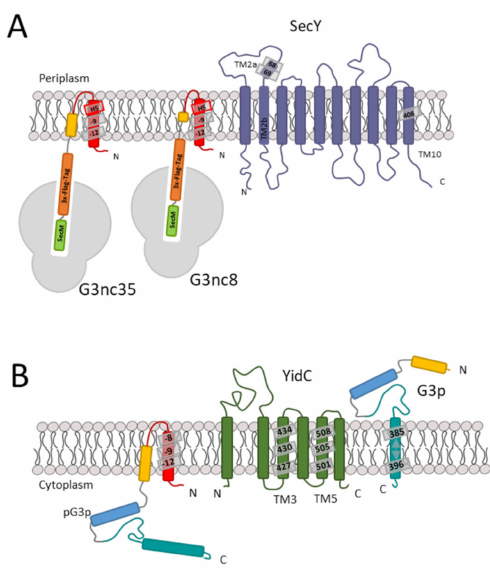
Figure 7. Stages of membrane insertion of G3p. ( A ) In the first stage, when the nascent chain of G3p exposing the signal sequence interacts with SecY of the translocase, namely in the plug region, the residues 68 and 69 are predominant. ( B ) In the second stage, the periplasmic region of G3p is translocated by SecA and SecYEG. The membrane anchor region of G3p is then inserted by contacting the YidC hydrophobic slide residues 427, 501 and